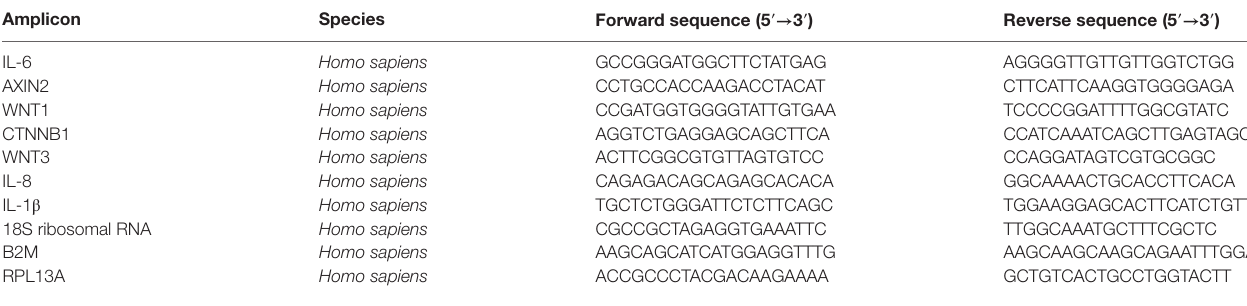
TaBle 1 | Primer sequences used.